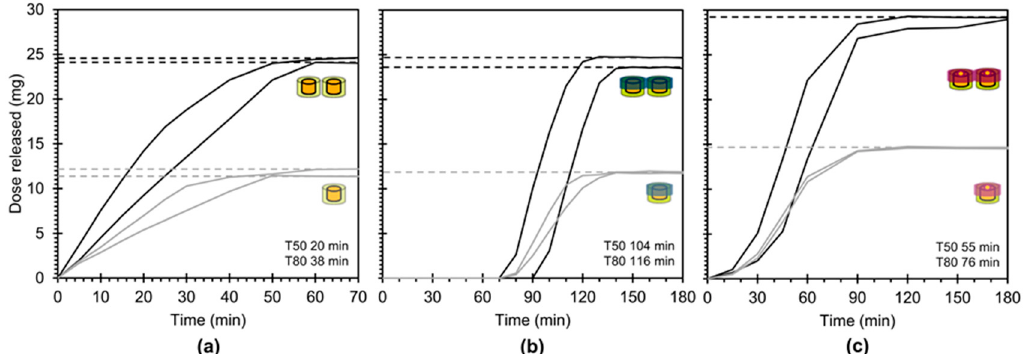
Figure 8. Dose released (mg) from dosage forms comprising two identical module variants: ( a ) MV1 + MV1; ( b ) MV2 + MV2; and ( c ) MV3 + MV3. As a reference, solid grey lines indicate dose released from single module variants. Data is presented as the minimum and maximum of n = 2 samples. Mean T50 and T80 values for the dosage forms are displayed in the bottom right of each figure. The solid lines represent minimum and maximum drug release kinetics for the dosage form variants (black) and module variants (grey). Three unique release profiles are shown for the dosage form variants comprising two identical module variants, analogous to that of the single module variants. The dose released (mg) corresponds to the complete drug release (100%) in all cases.